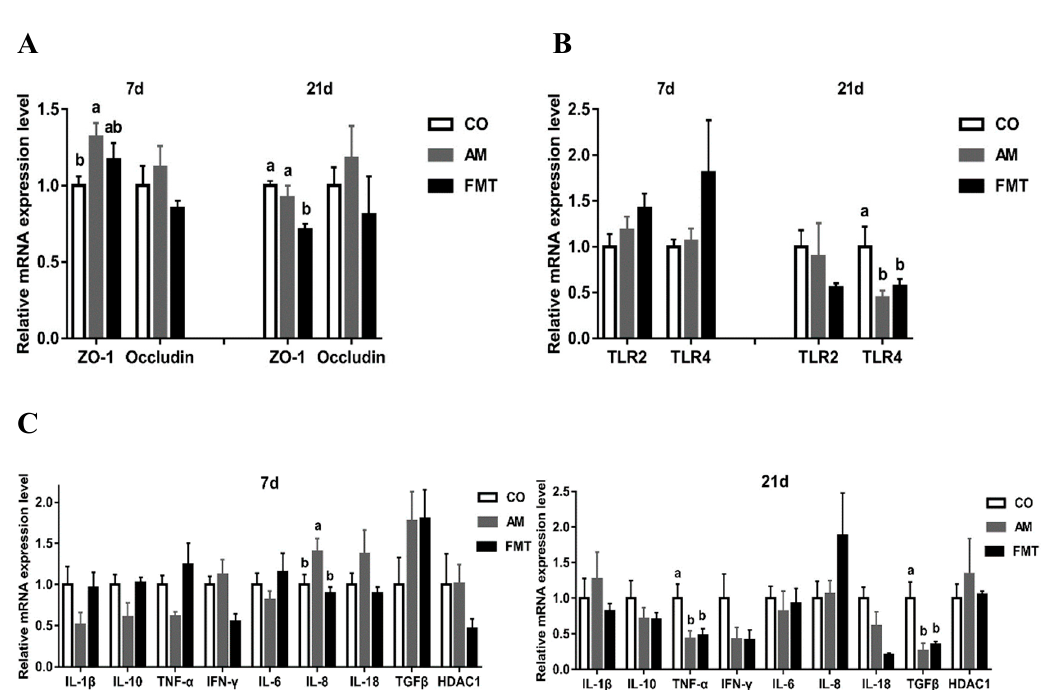
Figure 1. Relative mRNA expression of genes related to intestinal epithelial tight junction proteins ( A ), toll-like receptors and ( B ) inflammatory cytokines ( C ) in the ileum in the amoxicillin (AM), fecal microbiota transplantation (FMT), and control (CO) groups on days 7 and 21. Columns with different letters differ significantly ( p < 0.05).